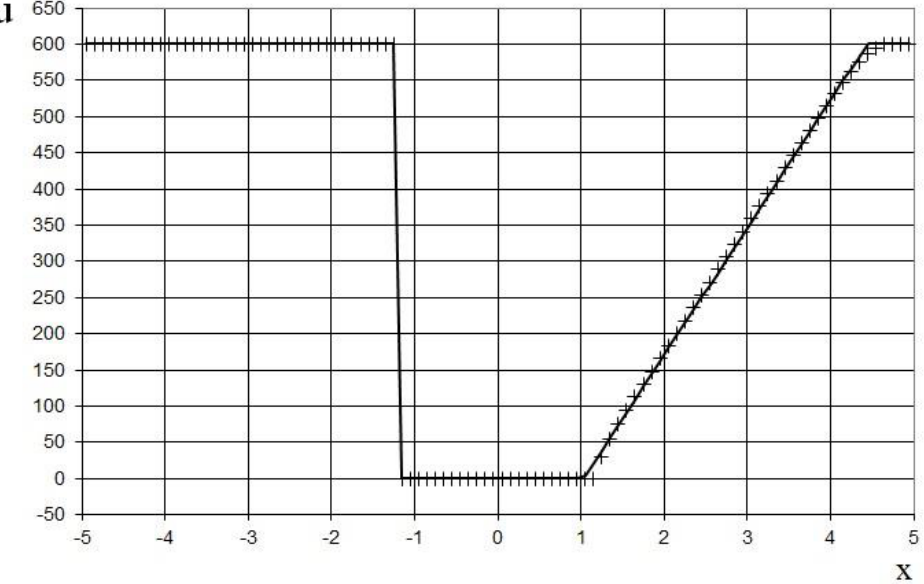
Figure 29. Density plot for the problem (54): the exact solution (line), and the present method (cross).